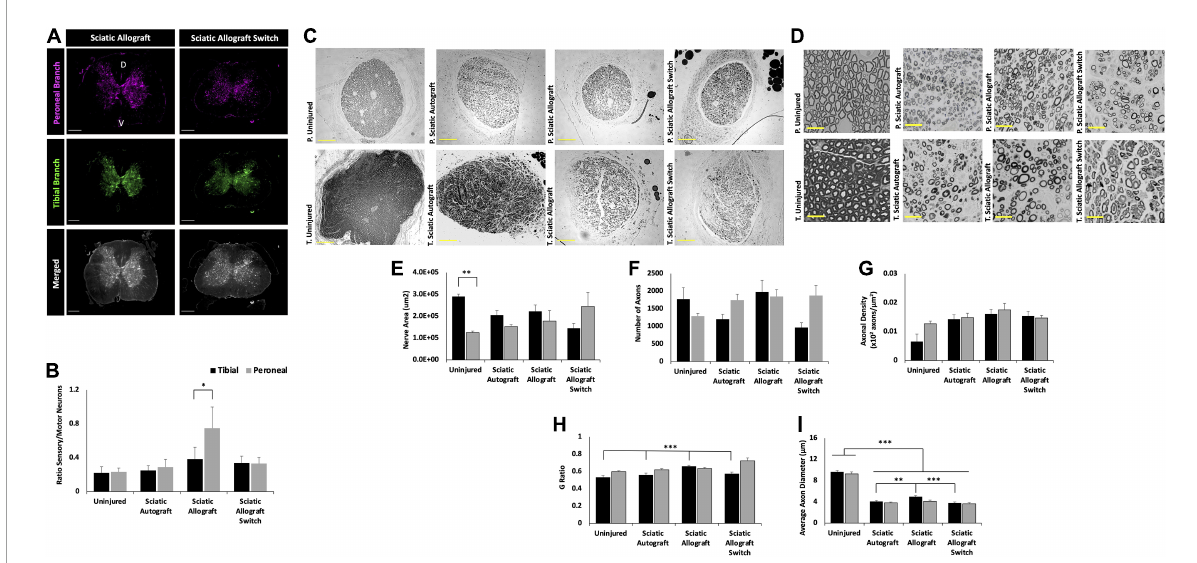
FIGURE6 Inbred Lewis to Lewis sciatic allograft and sciatic allograft switch group retrograde labeling and nerve morphometry. Sciatic autograft is included for reference. (A) Retrograde labeled spinal cords showing peroneal (magenta) and tibial (green) branch labeling. Scale bars are 500 µ m. (B) Ratio of sensory/motor neurons counted from the peroneal (magenta) and tibial (green) nerves. ∗ p < 0.05 by Wilcoxon Signed Rank Test comparing tibial and peroneal ratios. (C) Cross section images of the peroneal and tibial nerves taken at 10 × . Scale bars are 200 µ m. (D) 40 × images of the toluidine blue stained sections from within the grafts; labeling of images is based on connection of the branch in the graft to the hosts peroneal or tibial distal nerve stump. Scale bars are 20 µ m. (E) Total cross sectional nerve area taken for the tibial and peroneal branches. (F) Total number of axons. (G) Axonal density. (H) G-ratio. (I) Average inner x and y plane axon diameter. n = 5 for sciatic autograft, n = 6 for sciatic allografts in both orientations, ∗ p < 0.05, ∗∗ p < 0.01, ∗∗∗ p < 0.001 by two-way ANOVA with Tukey post-hoc test. Error bars are